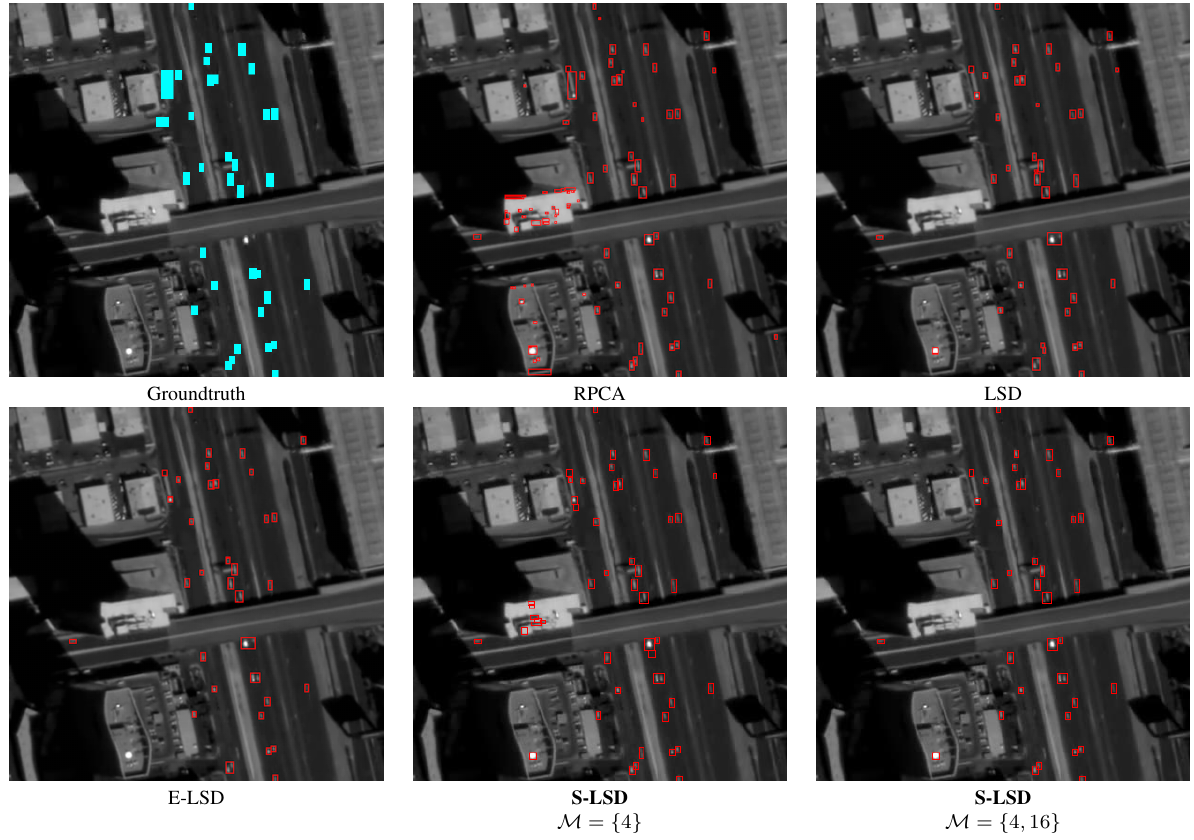
Figure 4. Detection results by different methods on Video 001.